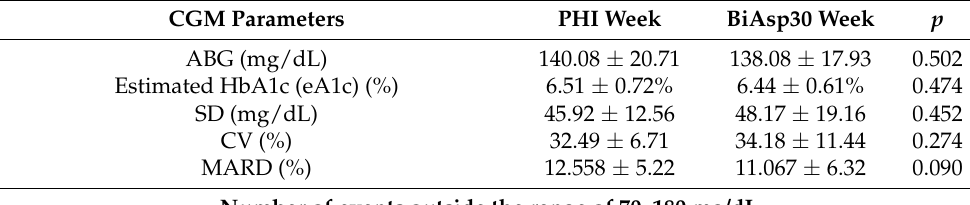
Table 2. A summary of the key CGM parameters for each of the PHI and BiAsp30